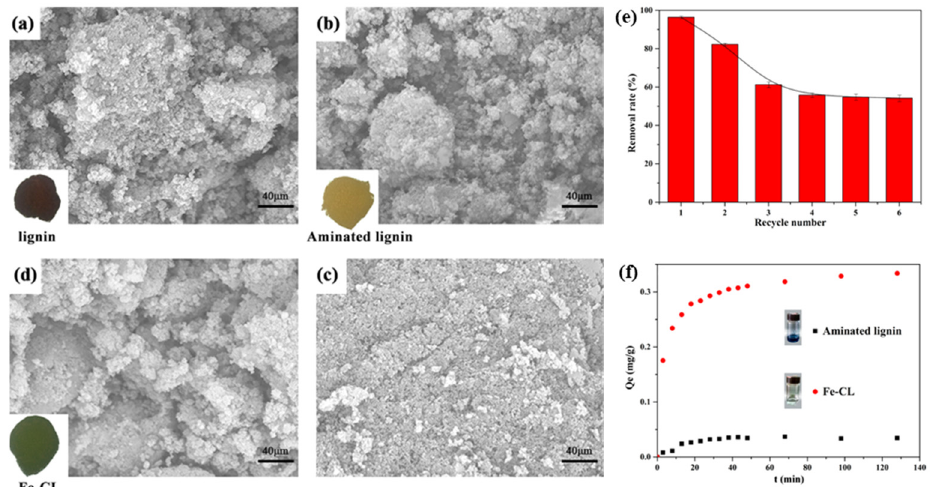
Figure 10. ( a – d ) SEM of lignin, aminated lignin, Fe-CL and phosphate-loaded Fe-CL; ( e ) Cycle adsorption of batch experiments for Fe-CL; ( f ) Phosphate adsorption kinetic of aminated lignin and Fe-CL. Reprinted with permission from Ref. [67]. Copyright 2017 American Chemical Society.